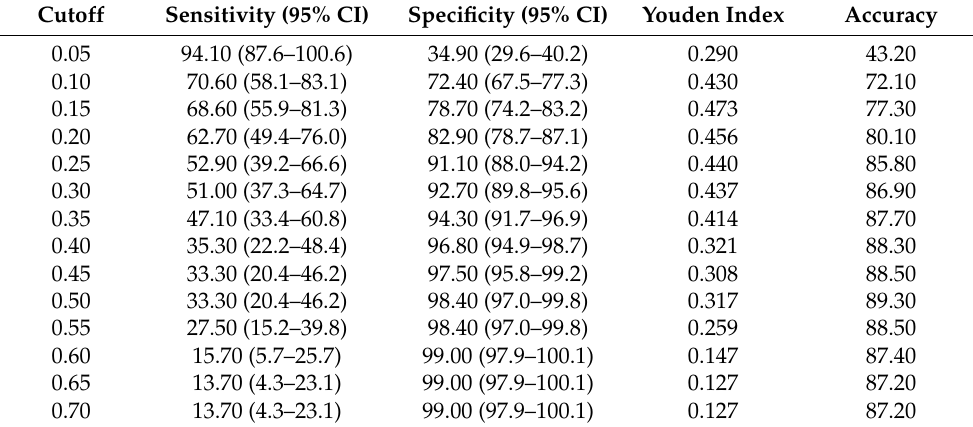
Figure 2. ROC curve of the adjusted multivariate model. Table 5. Sensitivity and specificity with 95% confidence intervals (CI), Youden index, and accuracy for the different cutoff